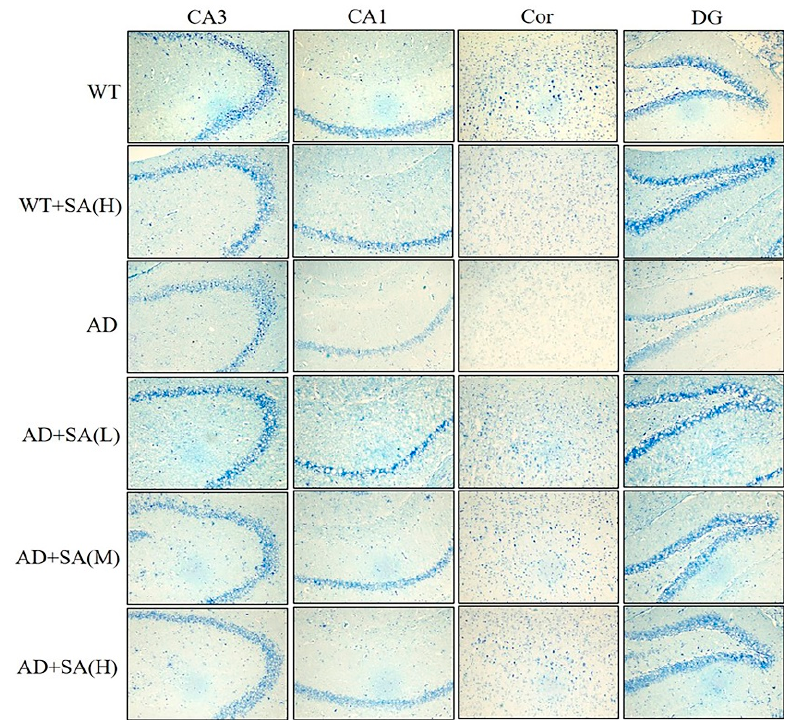
Figure 5. Effect of SA treatment on neuronal activity in the hippocampus and cortex of 2×Tg AD mice (4×) ( n = 4; scale bars = 50 μ m).